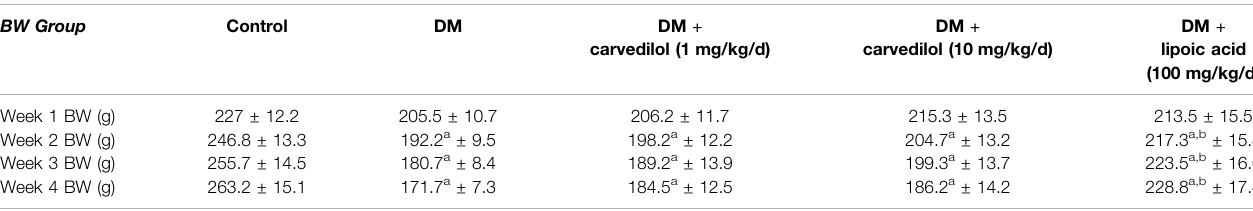
TABLE 2 | Effect of carvedilol on body weight in STZ-induced diabetes in rats.